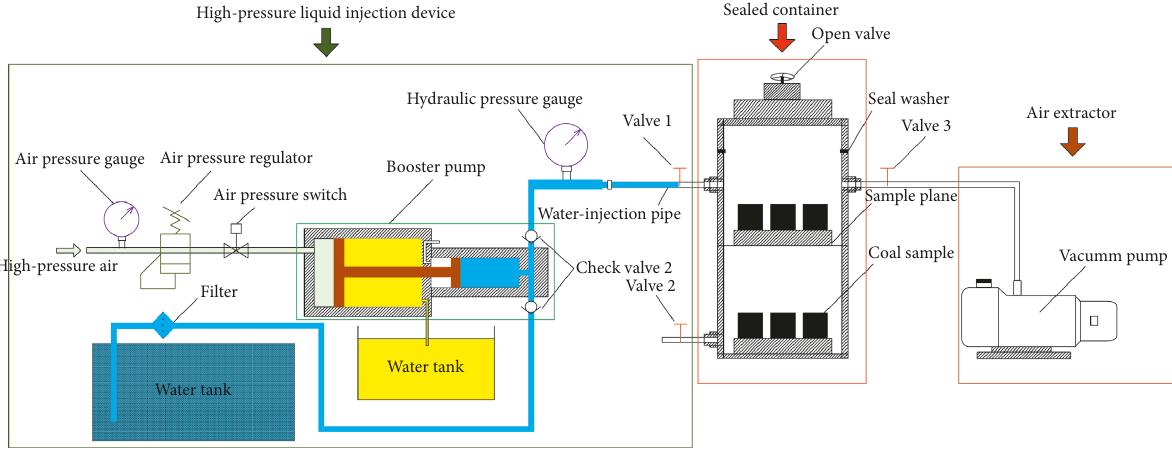
Figure 4: Experimental setup for preparing forcedly saturated coal